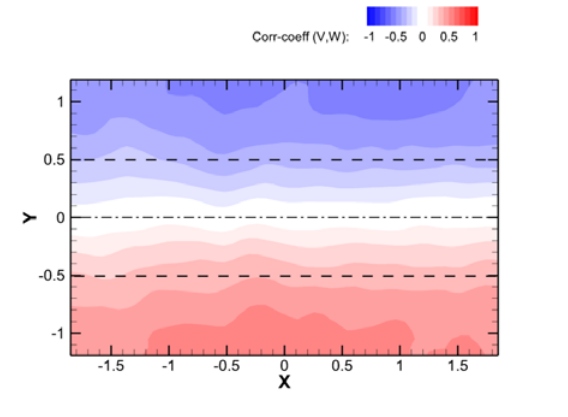
Fig. 4. (VW) correlation coefficient distribution .